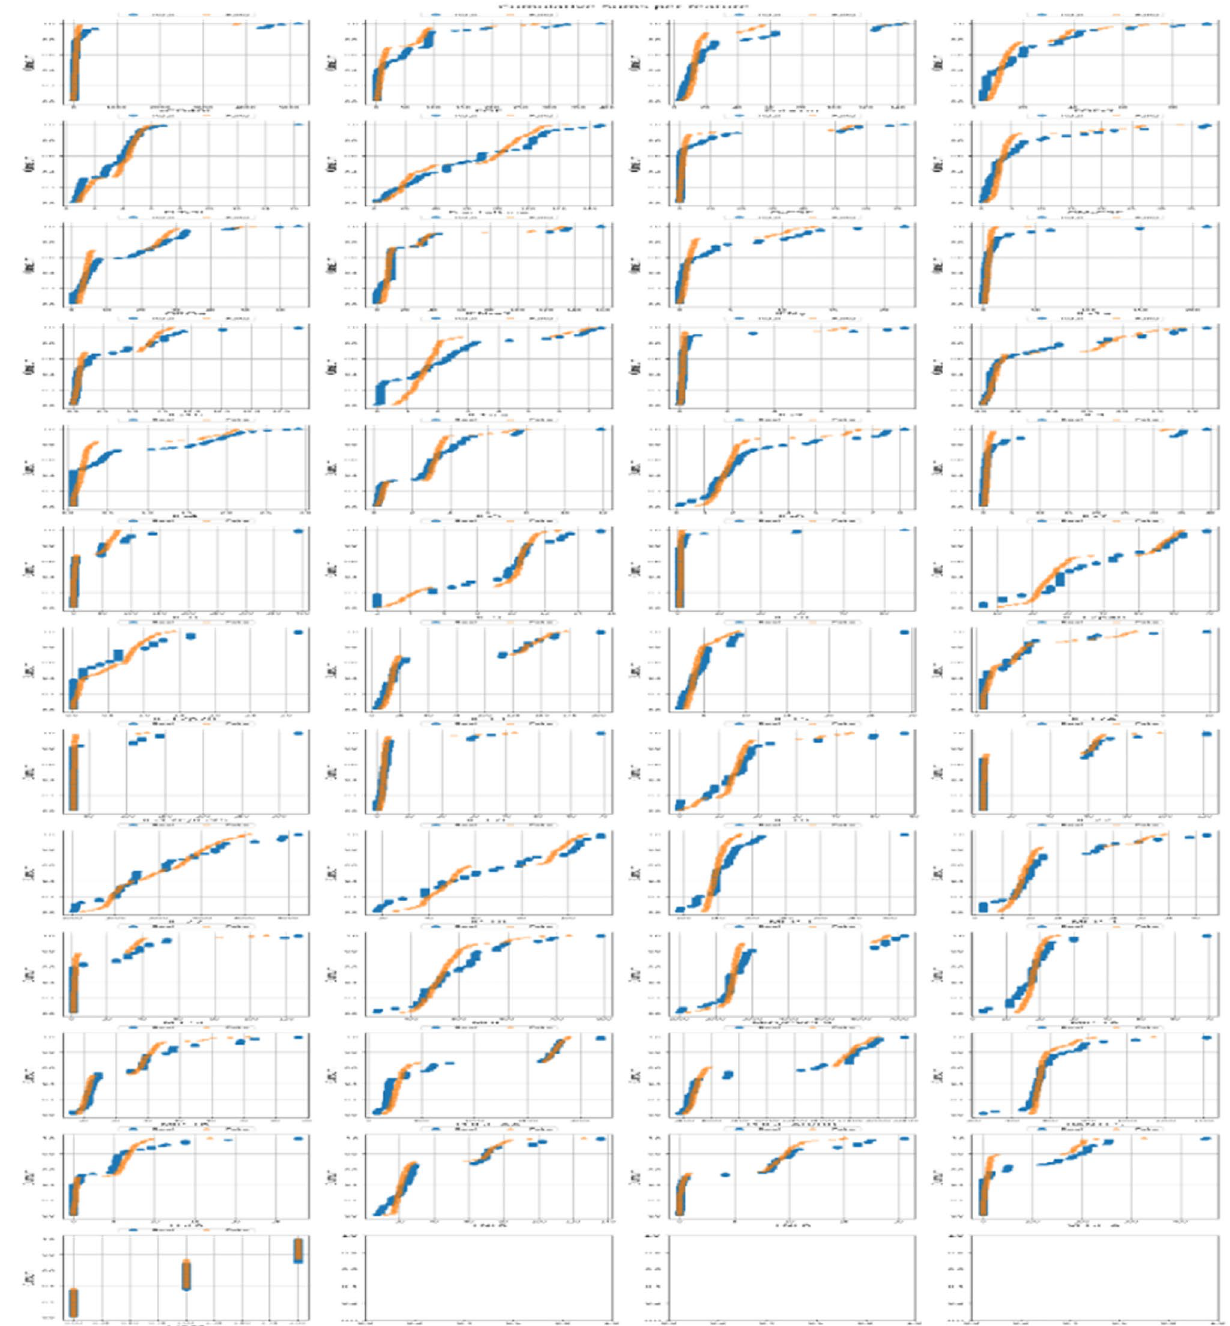
Figure 6. Plots of each feature in our actual dataset demonstrate the similarity between the synthesized and actual